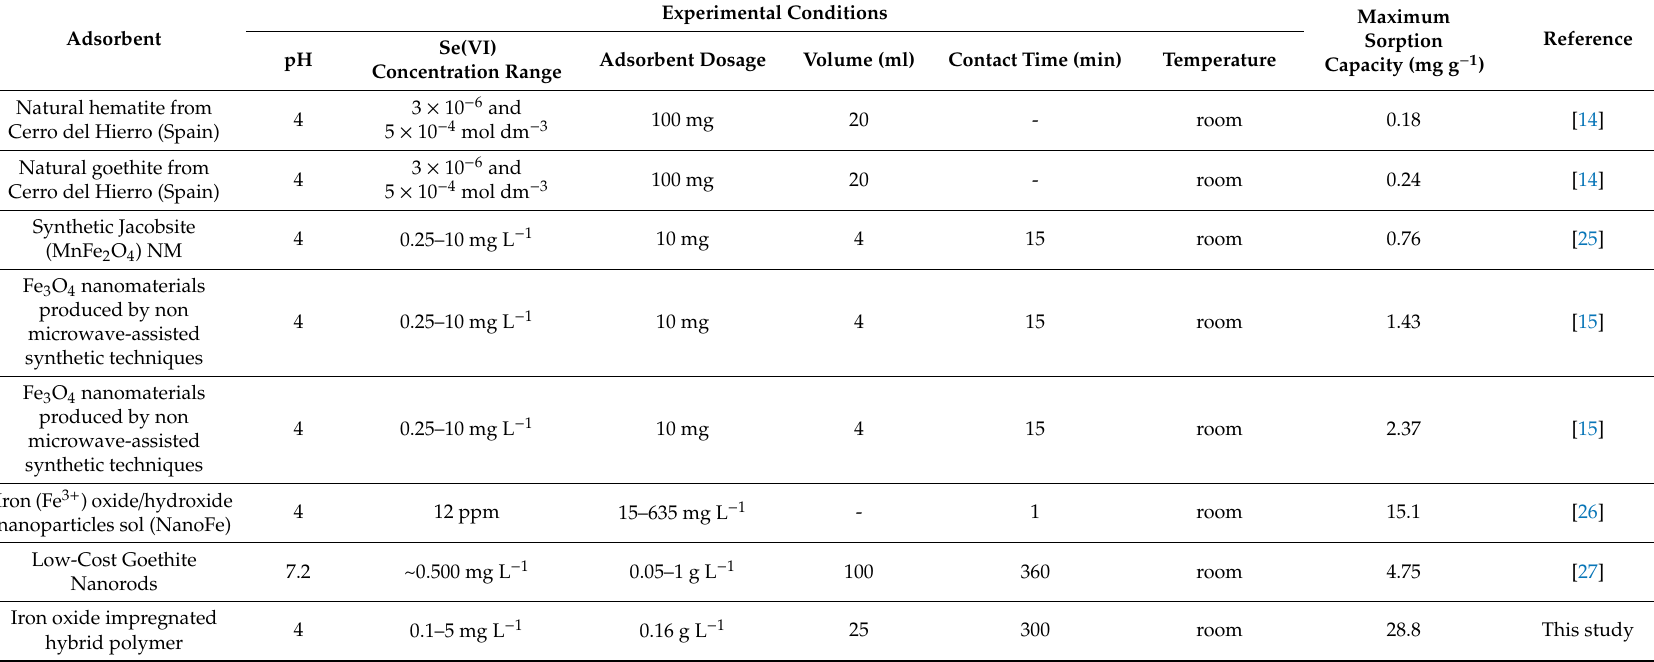
Table 8. Experimental conditions and uptake capacities of various iron containing sorbents for the selenate removal from water.